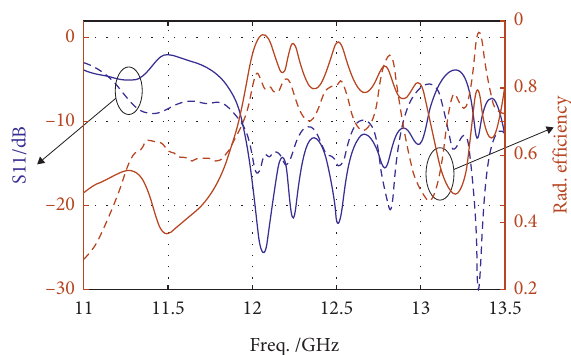
Figure 13: Comparisons of S parameters and the radiation effi- ciency, with red lines for S parameters and blue ones for the ra- diation efficiency, solid lines represent the simulated results, and the dashed lines represent the measurements.